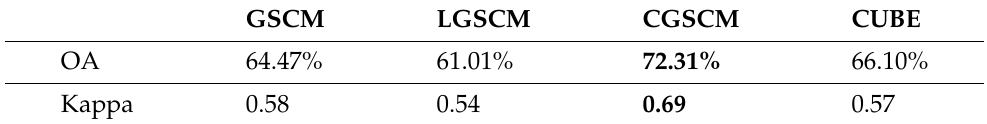
Table 3. Overall accuracy and kappa coefficients scored for the encodings used in Experiment one